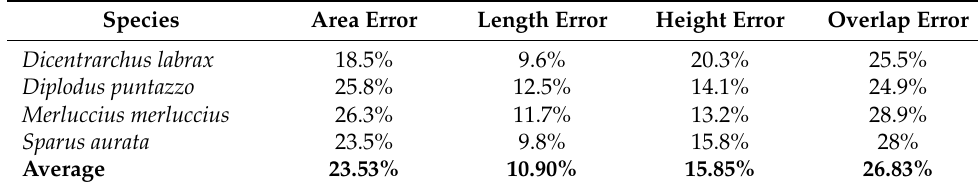
Table 3. Dimension errors for the deep learning SCIA approach described in Figure 11.